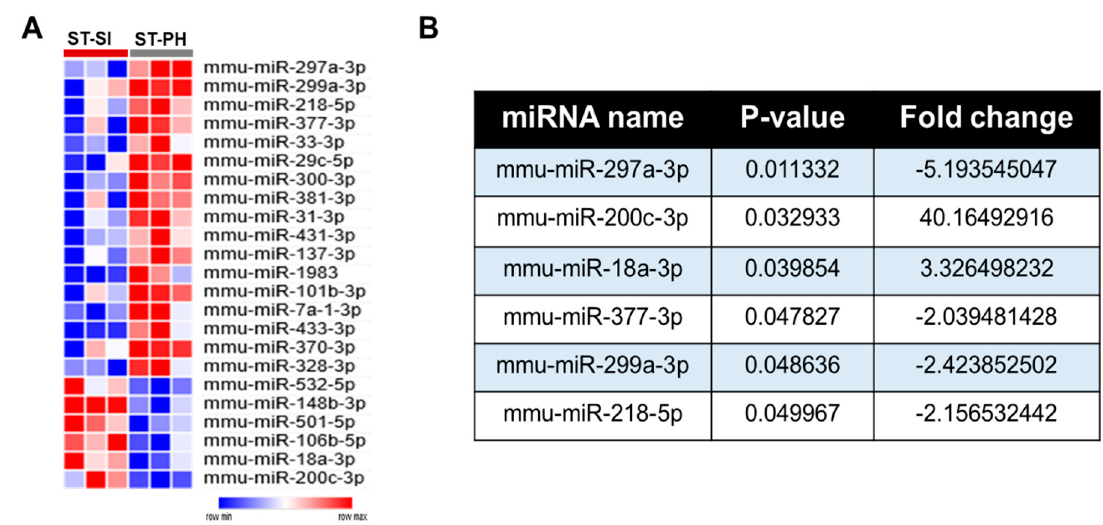
Figure 3. SI after stroke induces significant changes in brain miRNA profiles compared to PH. ( A ) 17 significantly upregulated and 6 downregulated miRNAs in the PH group compared to SI mice were identified and plotted as a heat map. ( B ) Further miRNAome analysis, based on the p value of p < 0.05 and a minimum fold change of 2 or higher, allowed us to identify the differentially regulated brain miRNAs between SI and PH stroke groups.